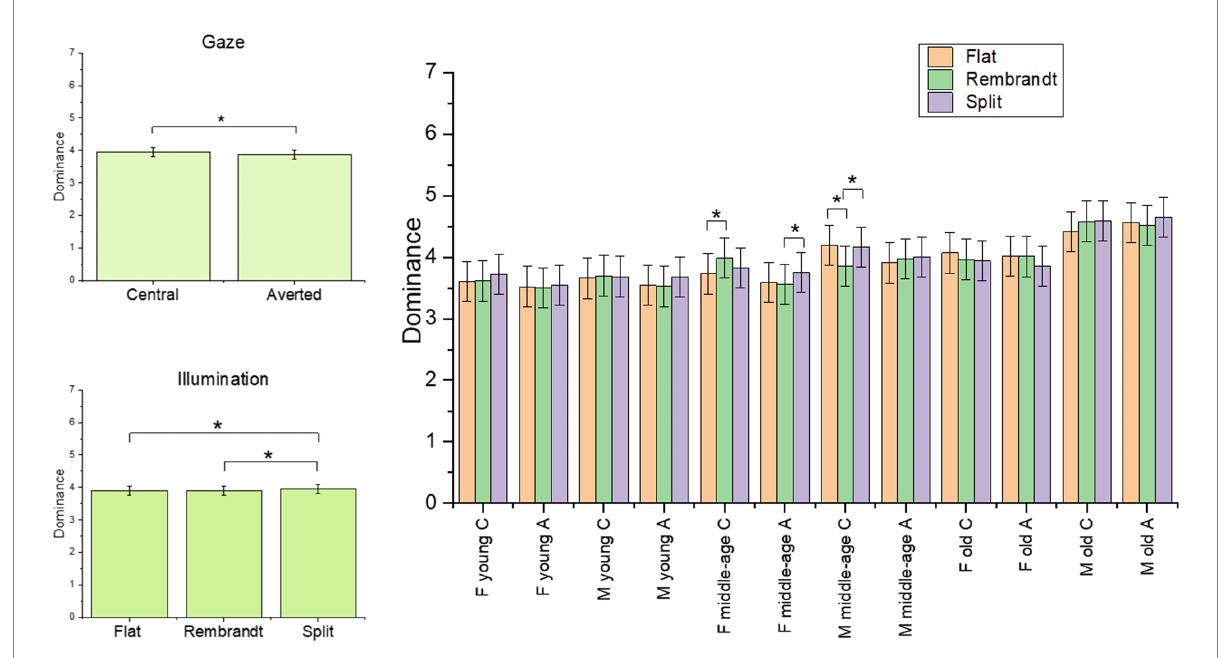
FIGURE 4 Plot of the estimated mean scores from the dominance rating, depicting significant main effects and higher order interaction. The asterisks highlight the significant main effect and significant results form post hoc analyses. C = central gaze, A = averted gaze, F = female models, M = male models. Error bars represent mean standard errors.